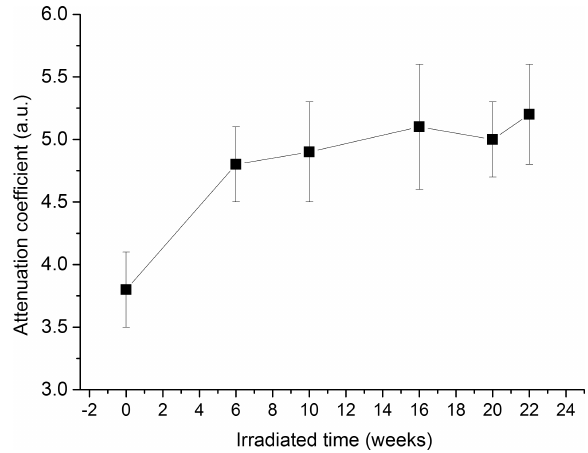
Fig. 3. The attenuation coe±cient of skin obtained from OCT scattering